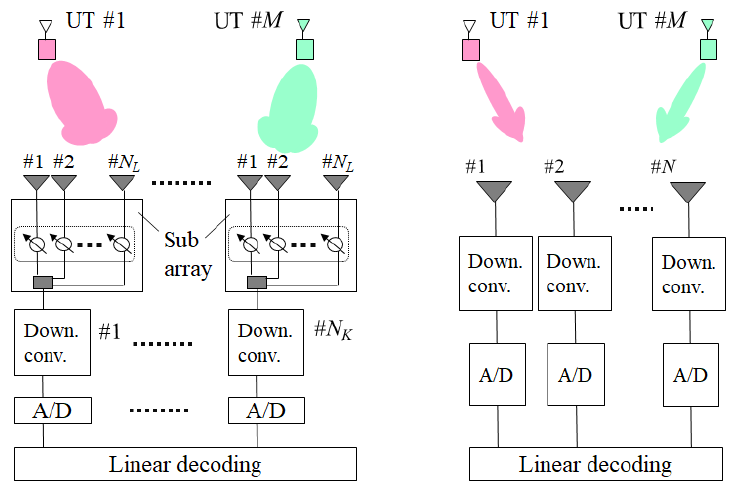
Figure 1. Uplink configurations of typical analog–digital hybrid ( left ) and full-digital ( right ) beamforming (BF) massive multiple-input multiple-output (MIMO) systems.